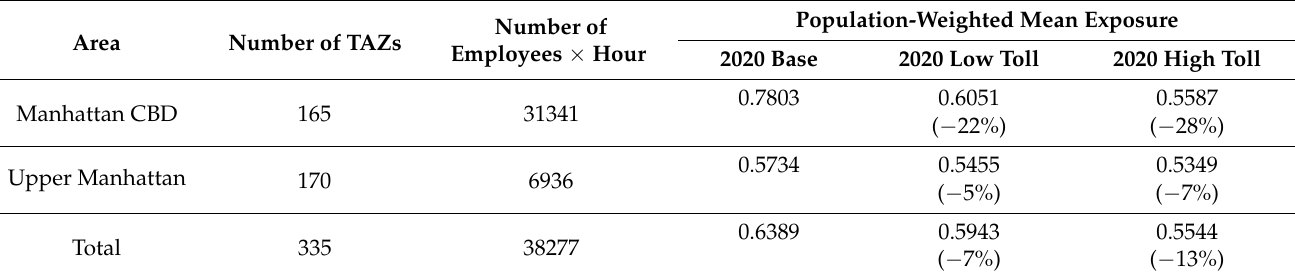
Table 2. Population-weighted mean of employee exposure to PM2.5 emissions for pricing scenarios. Population-Weighted Mean Exposure Number of Area Number of TAZs Employees × Hour